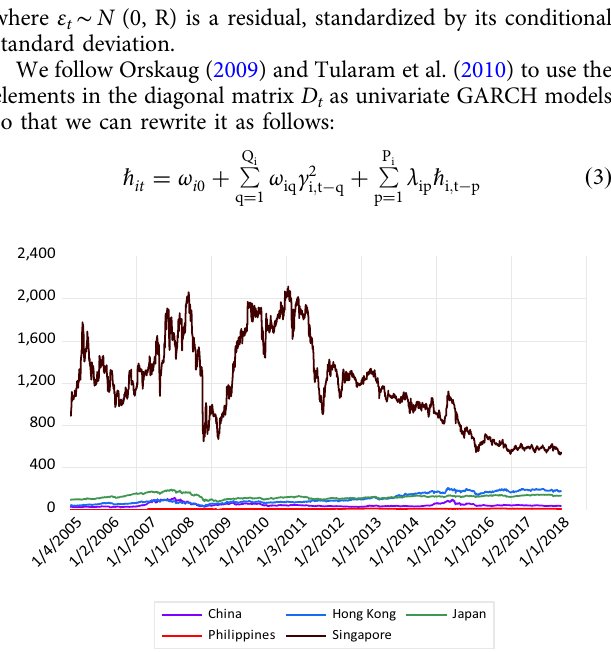
where ε t ∼ N (0, R) is a residual, standardized by its conditional standard deviation.